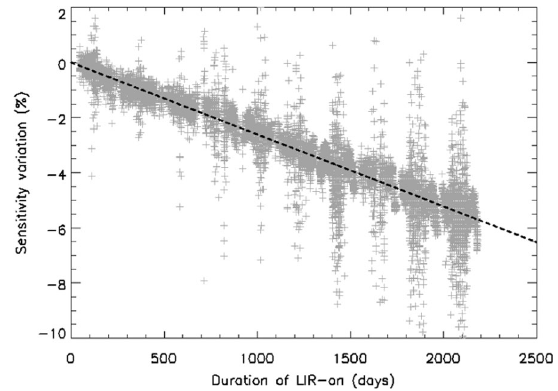
Fig. 4 The data in Fig. 1 after the correction for sensitivity